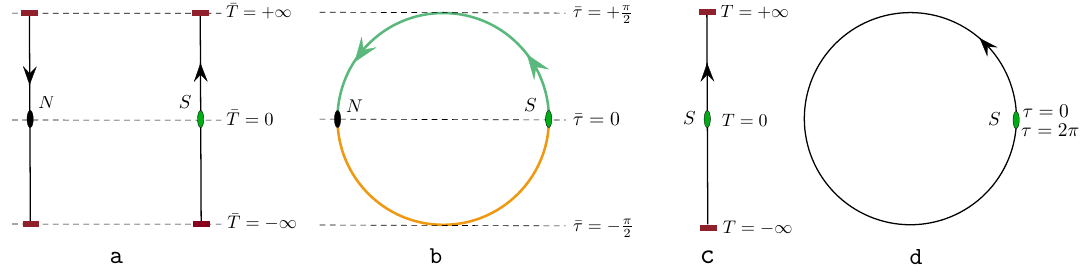
Figure 15 . dS 1 version of figure 14 (in c we only show S here). Wick rotation of global time ¯ T → − i ¯ τ maps a → b while wick rotation of static patch time T → − iτ maps c → d . Coordinates are as defined in tables D.10 and D.12 with d = 0